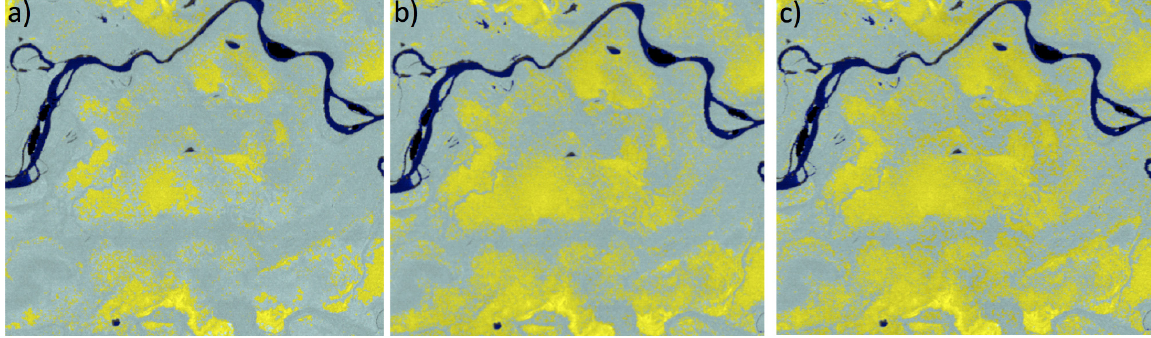
Figure 12. ( a ) Inundation classification for Pacaya_Samiria, Peru, and surrounding locations, overlaid on JERS-1 based wetland mask, centered on letter “c” in Figure 3. The black box is 45 km by 45 km. The colors of the inundation classification are overlaid on the JERS-1 based wetland mask, (light grey indicates inundatable and dark grey indicates outside the inundatable area; ( b ) ALOS ScanSAR estimated inundation dynamics for box shown in (a) depicting fractional total inundation versus time. yellow : always inundated vegetation; off-yellow : occasionally inundated vegetation; dark blue : always open water; medium blue : occasionally open water; brown (ALOS only) : high topographic slopes.